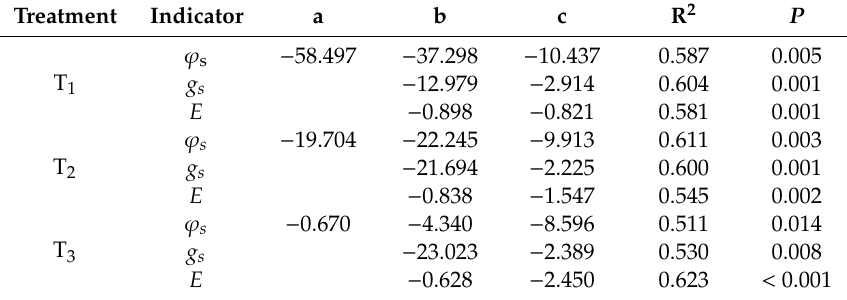
Figure 2. Relationships between T c - T a and plant-based water status indicators for three treatments. ( a ) stem water potential ( ϕ s ), ( b ) stomatal conductance ( g s ) and ( c ) leaf transpiration rate ( E ) for T 1 , T 2 and T 3 treatment. The di ff erent lines represent the fitting regression lines to the date. T 1 represents 100% M, T 2 represents 80% M, T 3 represents 60%. Table 5. Regression coe ffi cient and accuracy evaluation of fitting equation between T c - T a and plant water status